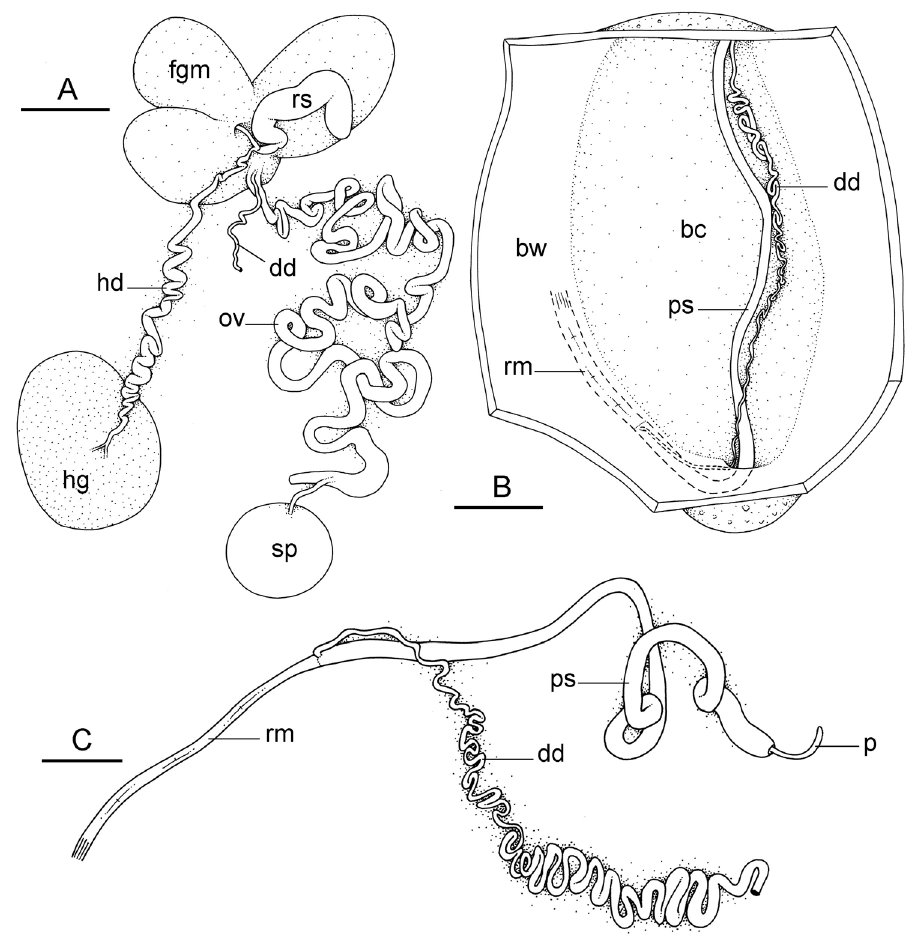
Figure 32. Reproductive system, Wallaconchis nangkauriense . A Hermaphroditic (female), posterior parts, Philippines, Bohol, scale bar 4 mm [3276] (PNM 041206) B Anterior, male copulatory parts, Indonesia, Sulawesi, scale bar 5 mm [2192] (UMIZ 00014) C Anterior, male copulatory parts (vestibule removed around the penis), Indonesia, Sumatra, scale bar 2 mm [1788] (UMIZ 00012). Abbreviations: bc body cavity bw lateral left body wall dd deferent duct fgm female gland mass hd hermaphroditic duct hg hermaphroditic gland ov oviduct p penis ps penial sheath rm retractor muscle rs receptaculum seminis sp